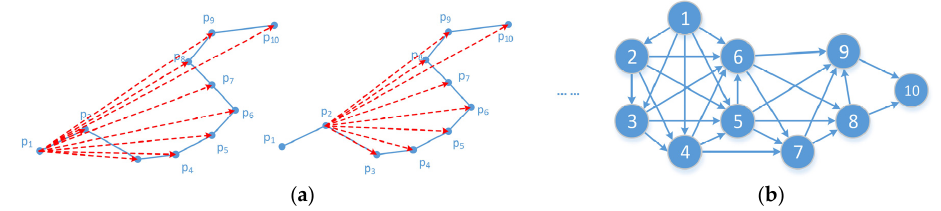
Figure 4. ( a ) The process of the Edge Test. ( b ) The trajectory graph.